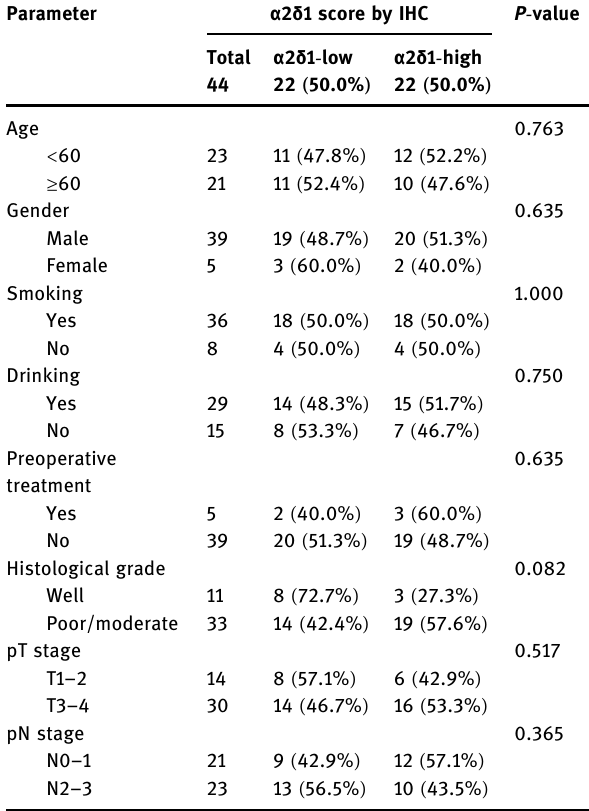
Table 1: Association of α 2 δ 1 expression in